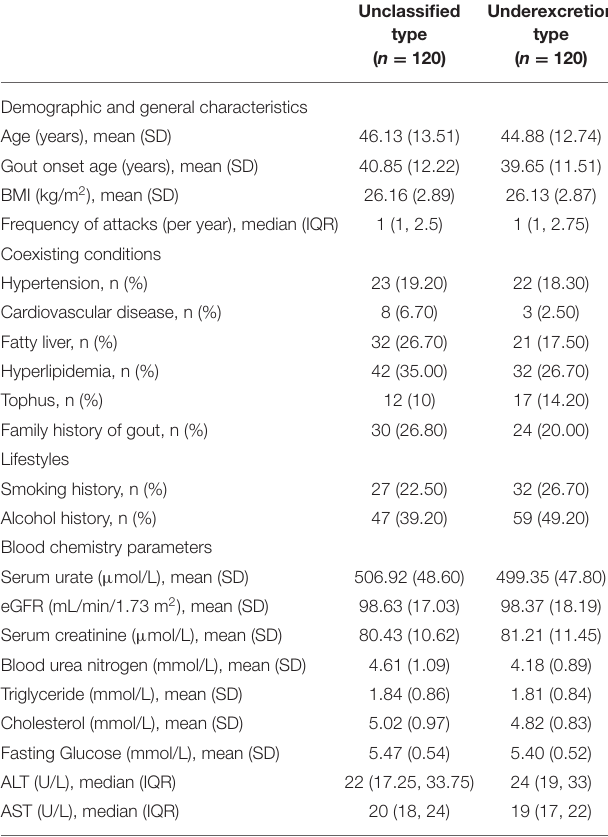
TABLE 1 | Baseline characteristics of the subjects.